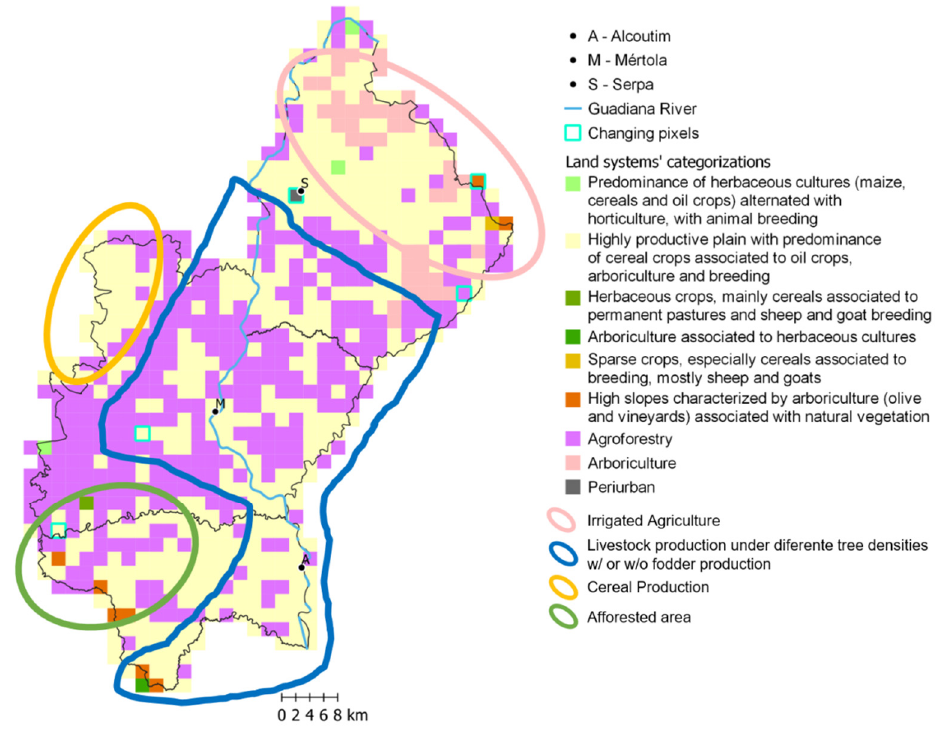
Figure 3. Land systems as characterized in the spatial analysis by Fusco et al. [30,31] at 2 × 2 km pixels and as described by the territorial actors (drawn shapes over the map).